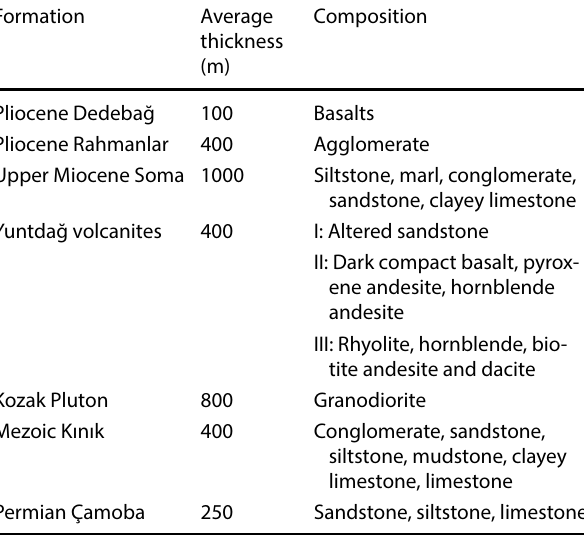
Table 1 Formation characteristics of the columnar stratigraphy in Dikili region [3, 20, 33,